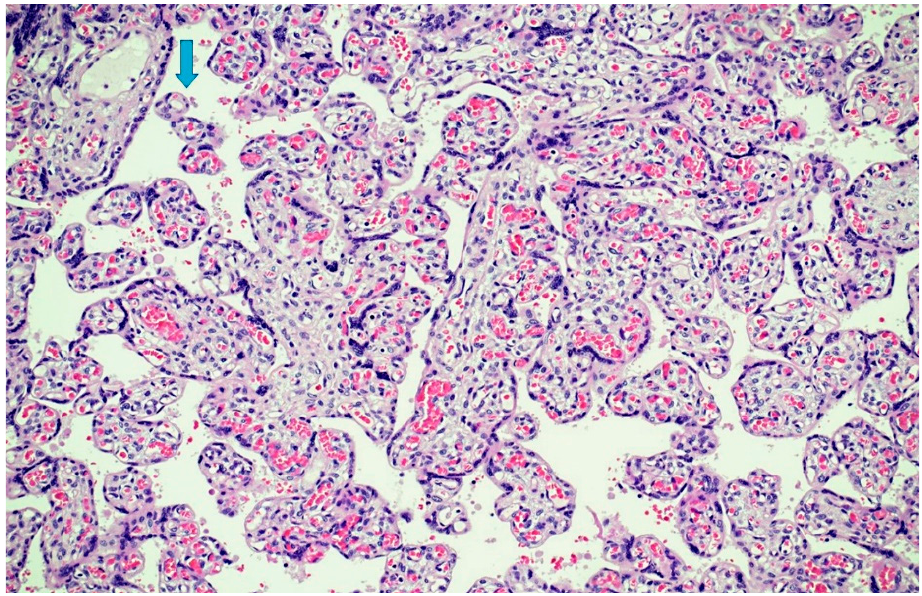
Figure 6. Parenchymal dysmaturity: chorionic villi showed diffuse delayed villous maturation with plump villi and rare terminal villi (arrow)(Hematoxylin and Eosin staining, 4 HPF).